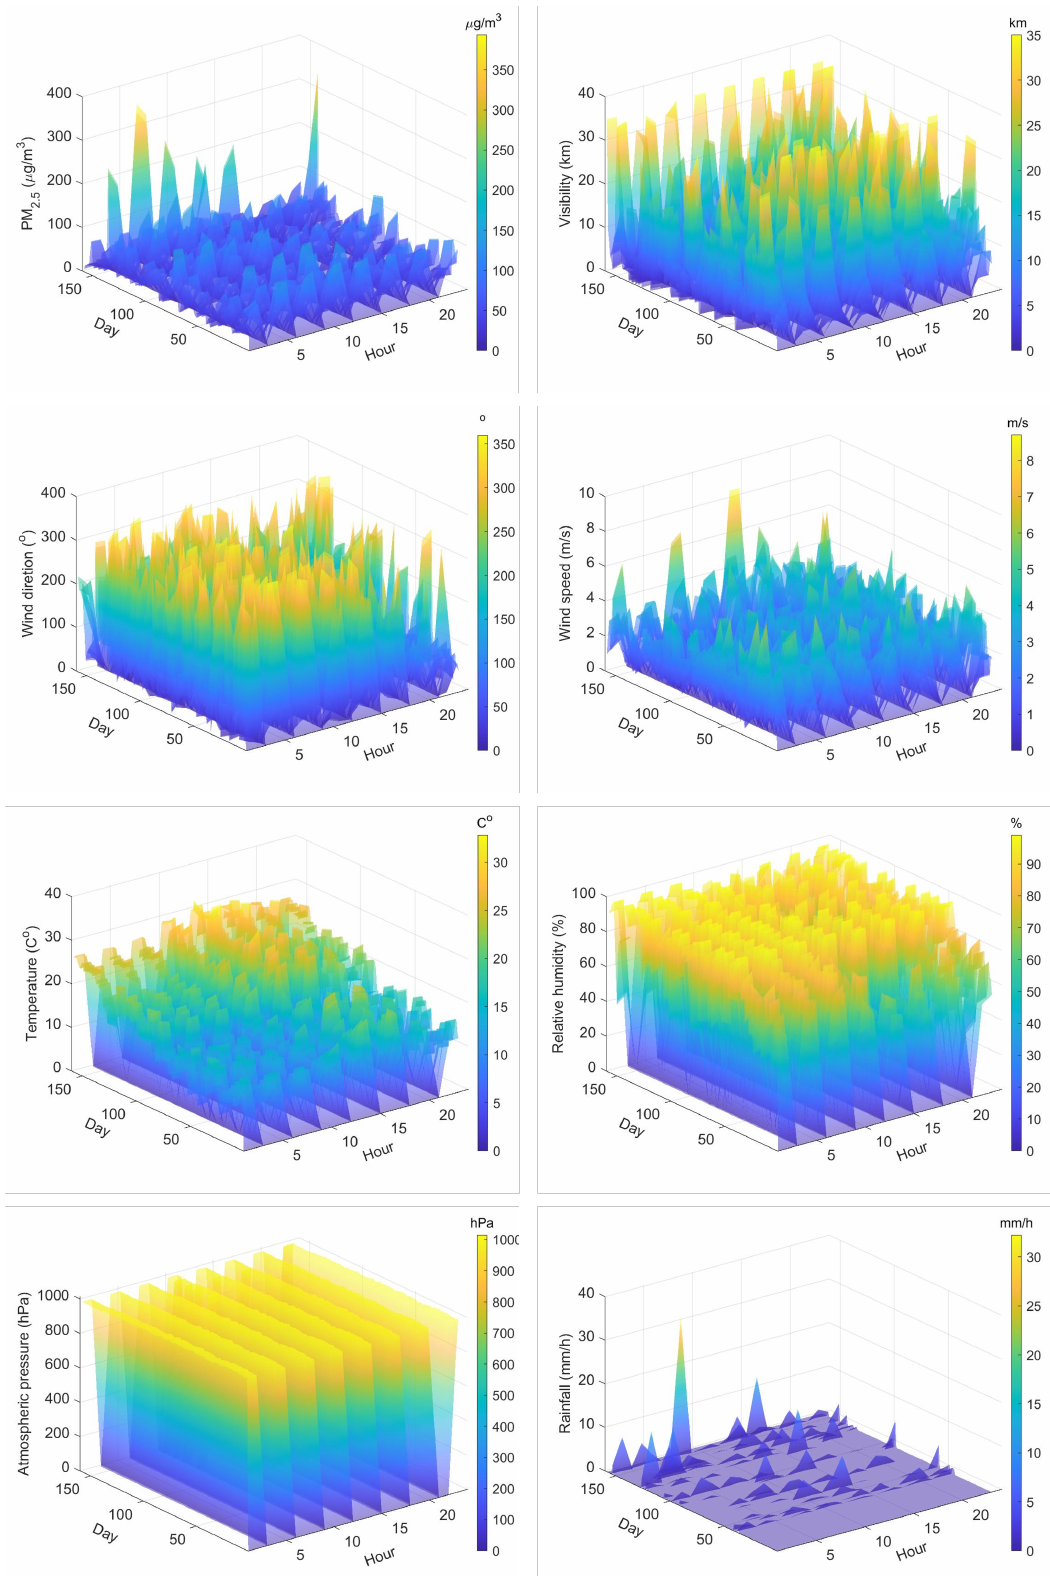
Figure 2. This figure shows two-dimensional temporal variations of PM 2.5 concentrations and meteorological parameters by 24 hours per day in the period of Jan 2014 – June 2014.